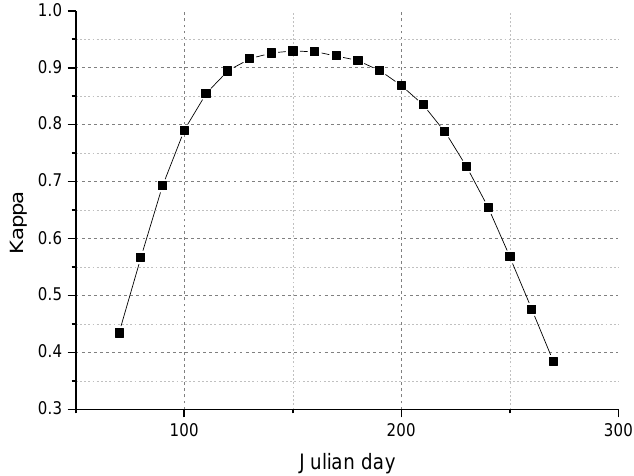
Figure 9. Kappa coefficients for mapping cotton under different thresholds.